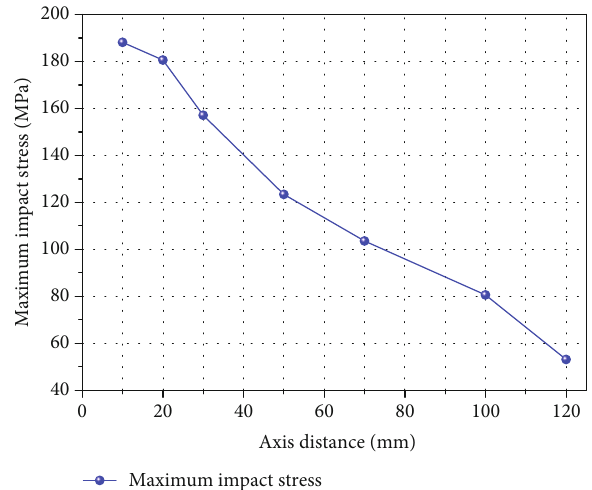
Figure 6: Impact pressure of HPWJ on the plate at di ff erent target